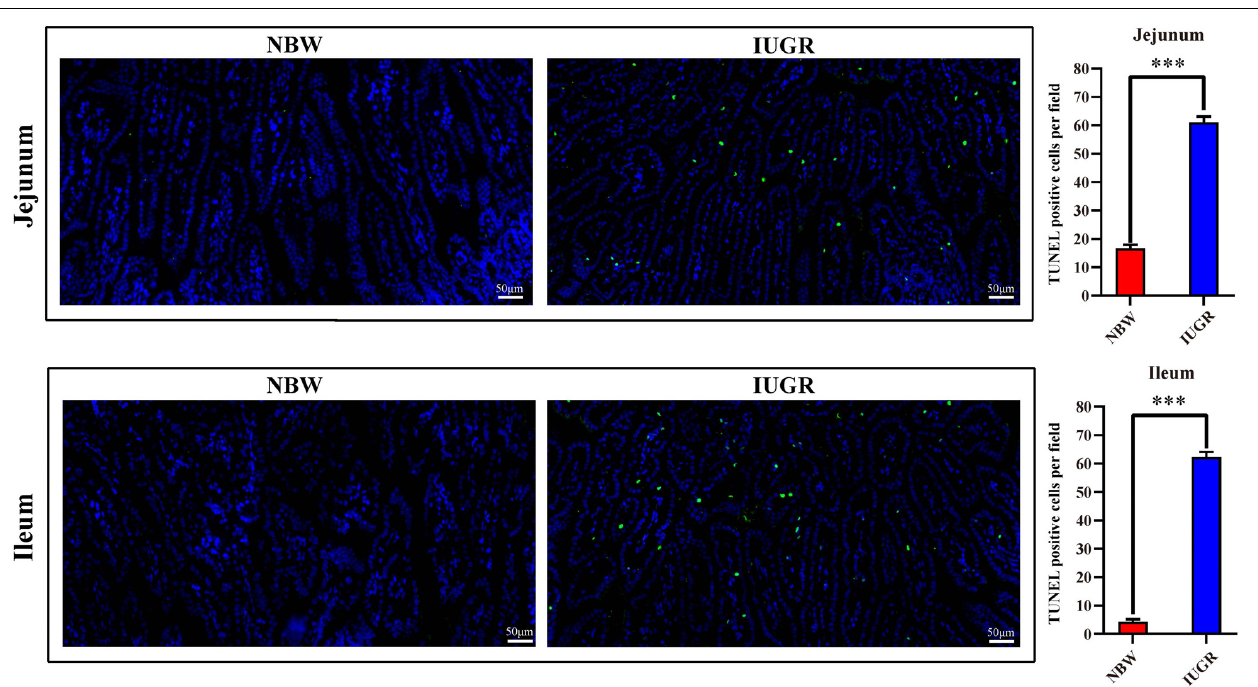
FIGURE 6 | Apoptosis analysis on jejunum and ileum by TUNEL in NBW and IUGR piglets. Data are shown as mean ± SEM. ∗∗∗ P < 0.001. n = 3 per group. TUNEL, terminal deoxynucleotidyl transferase dUTP nick end labeling; NBW, normal body weight; IUGR, intrauterine growth restriction. Bar = 50 µ